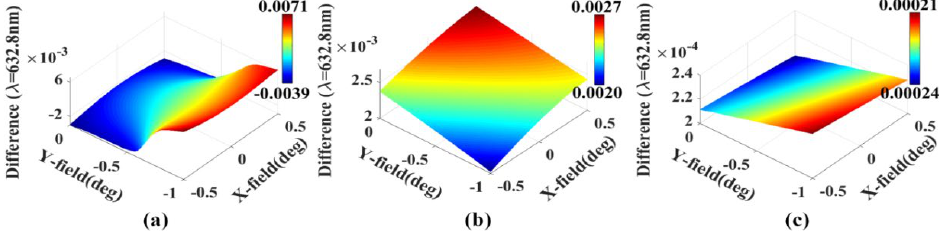
Figure 5. The full-field distribution of ( a ) C5/6, ( b ) C7/8, and ( c ) C9 differences before perturbation and after compensation adjustment of the off-axis TMA telescope.